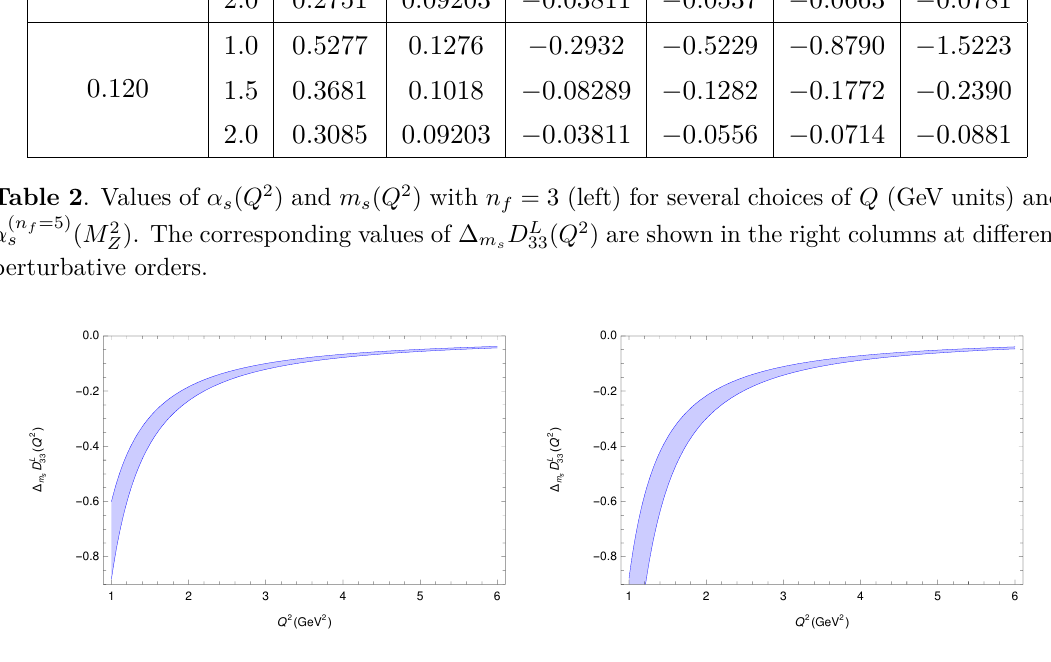
D L ( Q 2 ) for α ( n f =5) s ( M 2 33 s